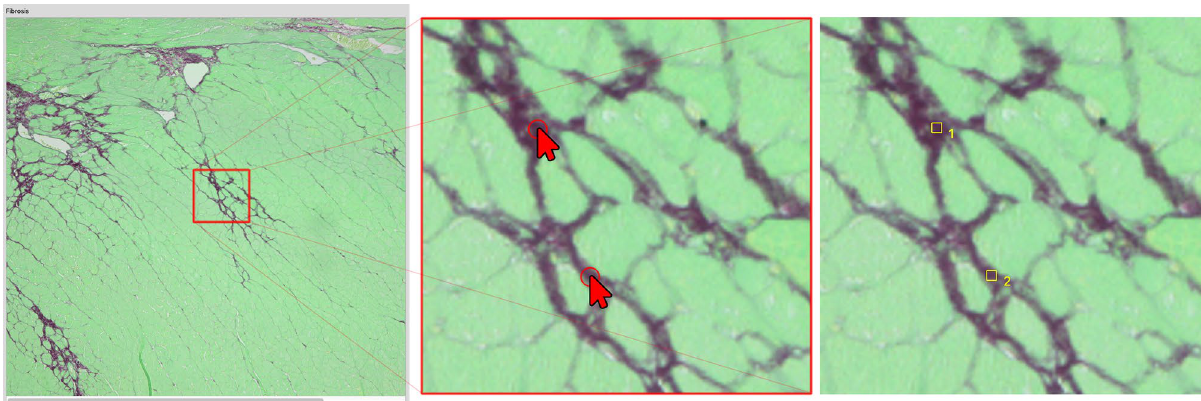
Figure 2. Quantification tool with sample selection panel and one sample for each tissue